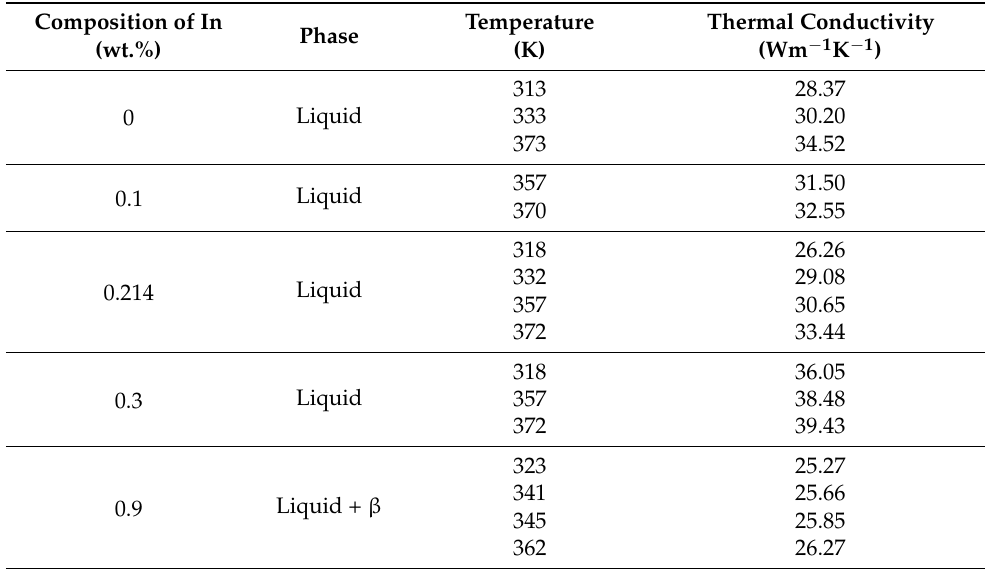
Table 1. Thermal conductivity values measured using modified comparative cut bar technique for liquid and semi-liquid Ga-In alloys at different compositions and